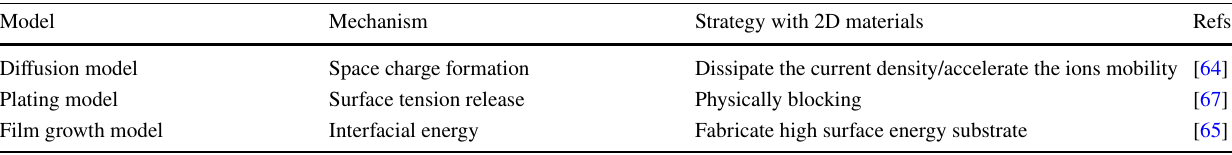
Table 1 Theoretical models of dendrite growth and corresponding strategies using 2D materials